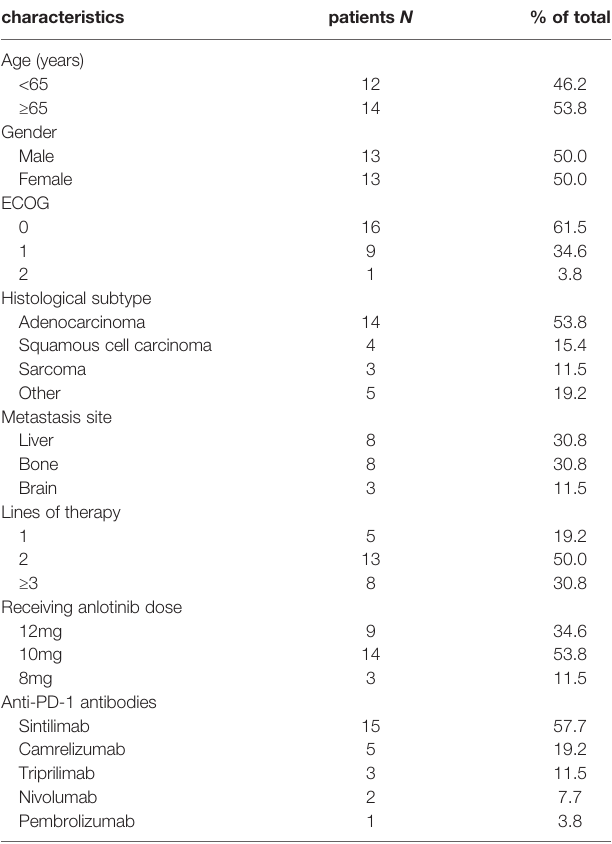
TABLE 2 | Demographics and baseline characteristics of patients.